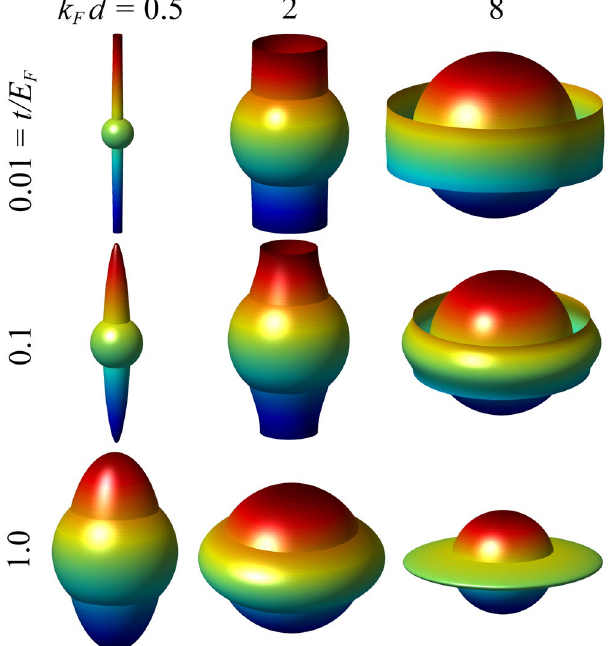
Figure 1. Evolution of the Fermi surface of the lattice component as a function of t and d , as compared with that of the 3D component (represented by the sphere). The Fermi surface is more like quasi-1D for small d and quasi-2D for large d .